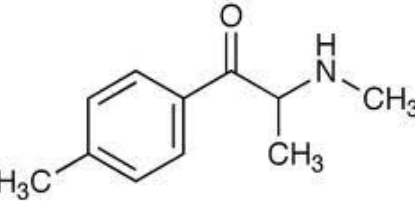
Figure 1. Molecular structure of mephedrone.